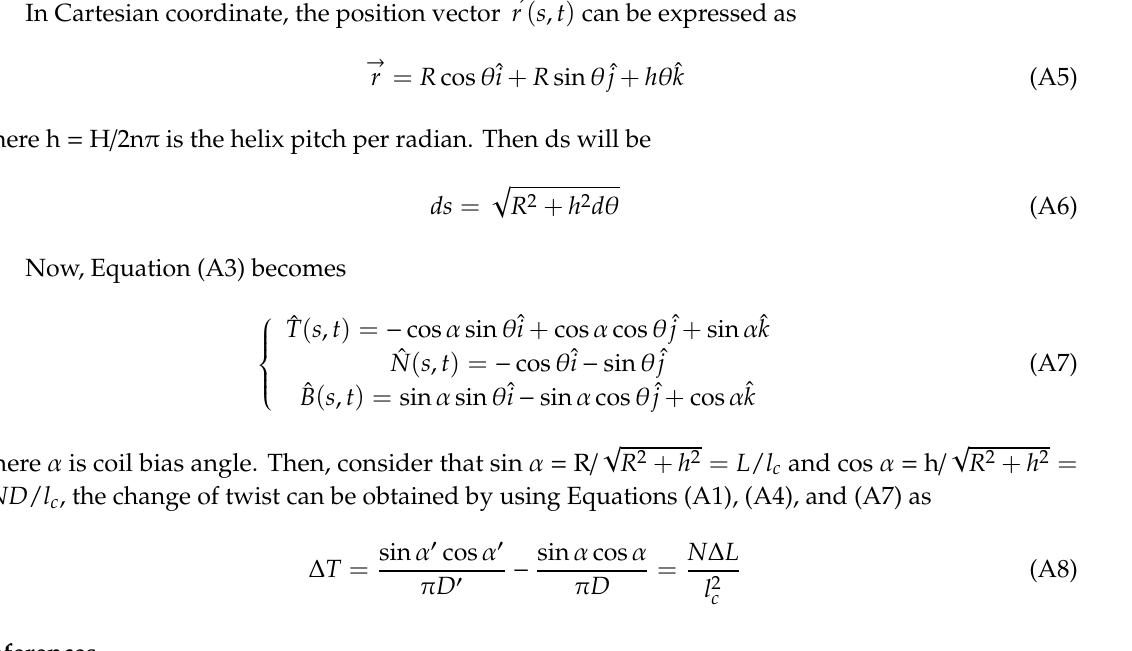
Figure A1. Illustration of Frenet–Serret frame